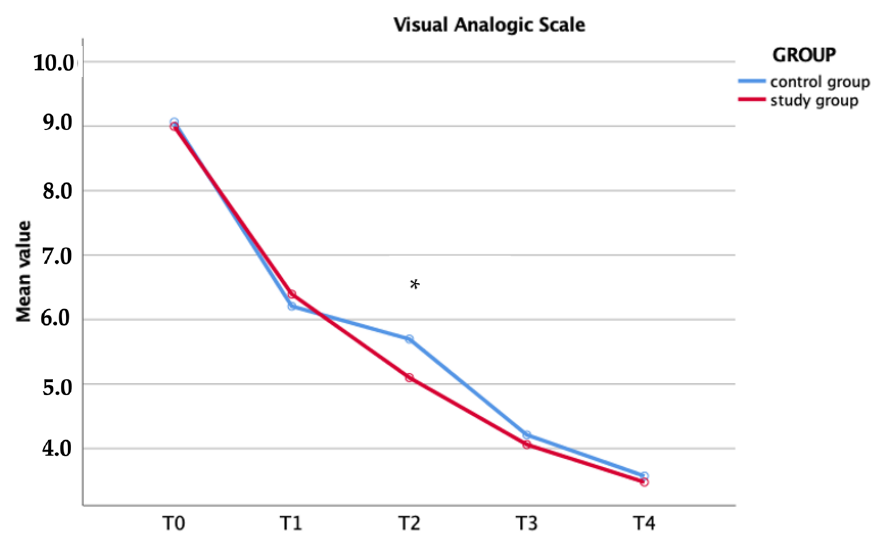
Figure 3 Visual analogic scale within each group (* p = 0.01). Figure 3. Visual analogic scale within each group (* p =